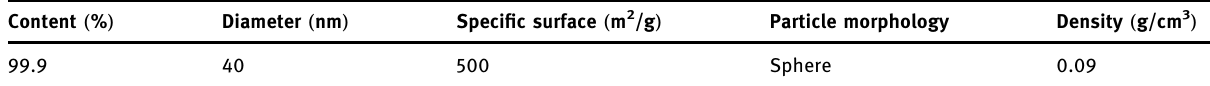
Table 4: Properties of nano carbon black